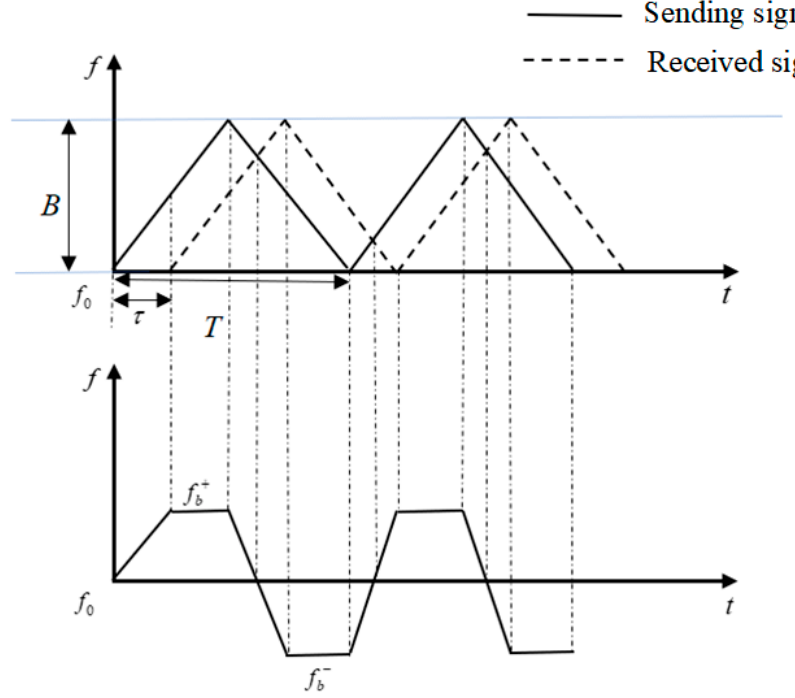
Figure 1. Time-frequency diagram of LFMCW radar.